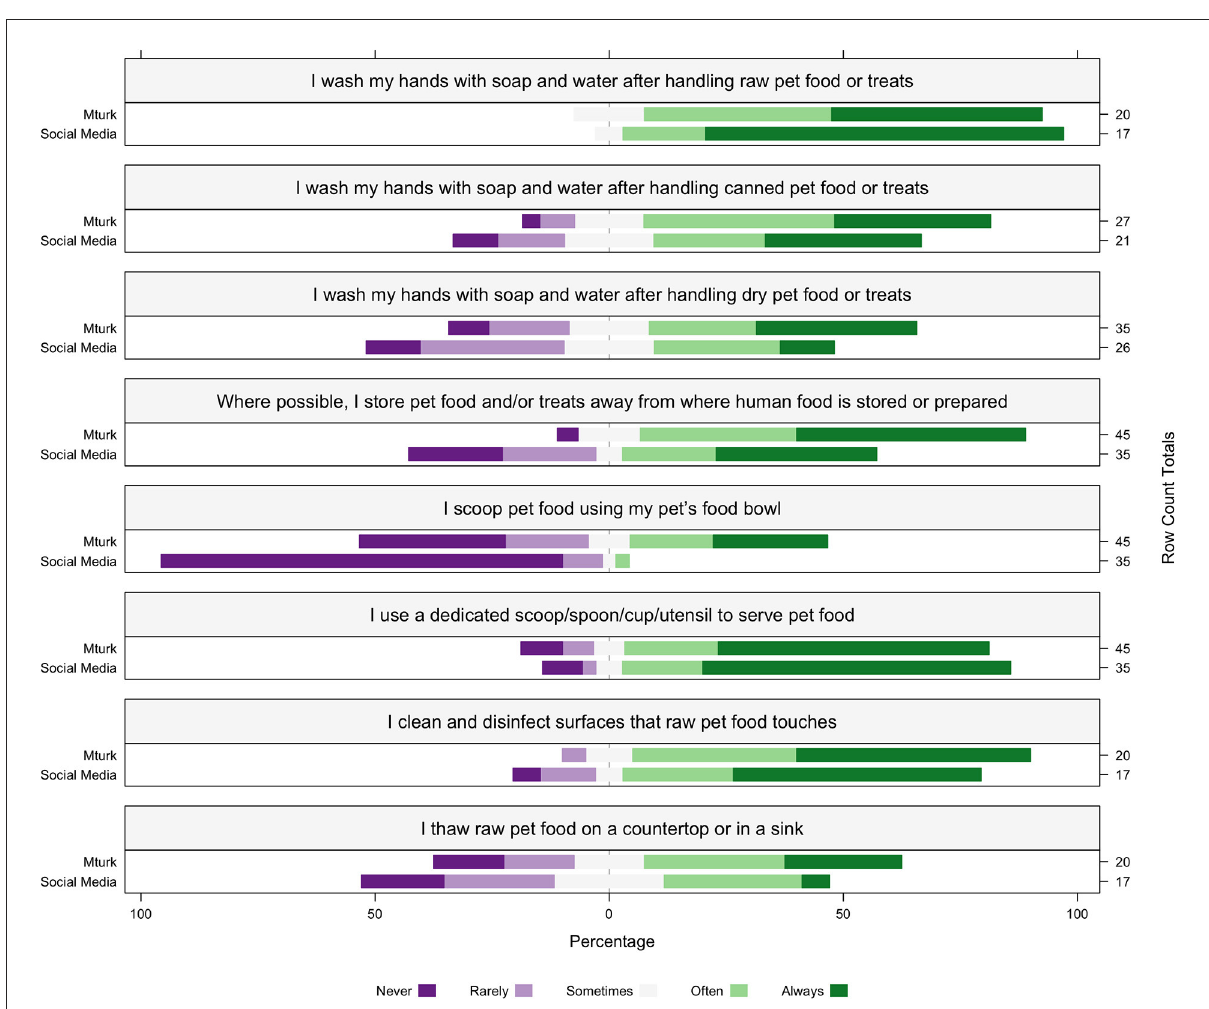
FIGURE2 The percentage of participants within each recruitment source of MTurk (MT; n = 45) and social media (SM; n = 35) that engage in pet food safety practices when feeding pets raw (MT n = 20, SM n = 17), canned (MT n = 27, SM n = 21) and dry (MT n = 35, SM n = 26) pet food and treats. Participants reported to “Never,” “Rarely,” “Sometimes,” “Often,” or “Always” engage in each activity listed in the box above each corresponding plot. The percentage of participants is represented on the x-axis, the recruitment source is represented on the left y-axis, and the row count totals (the number of participants for each question within each recruitment source) are listed on the right y-axis for each